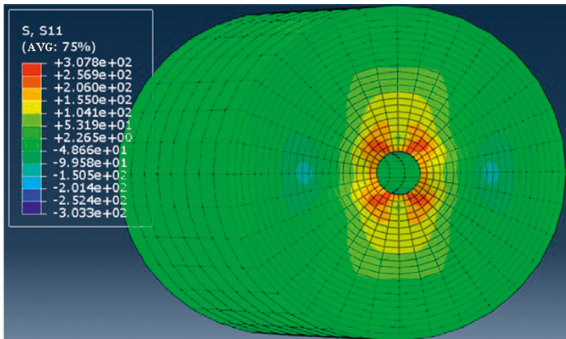
Figure 24: Stress cloud of middle layer S11 in 400% compression